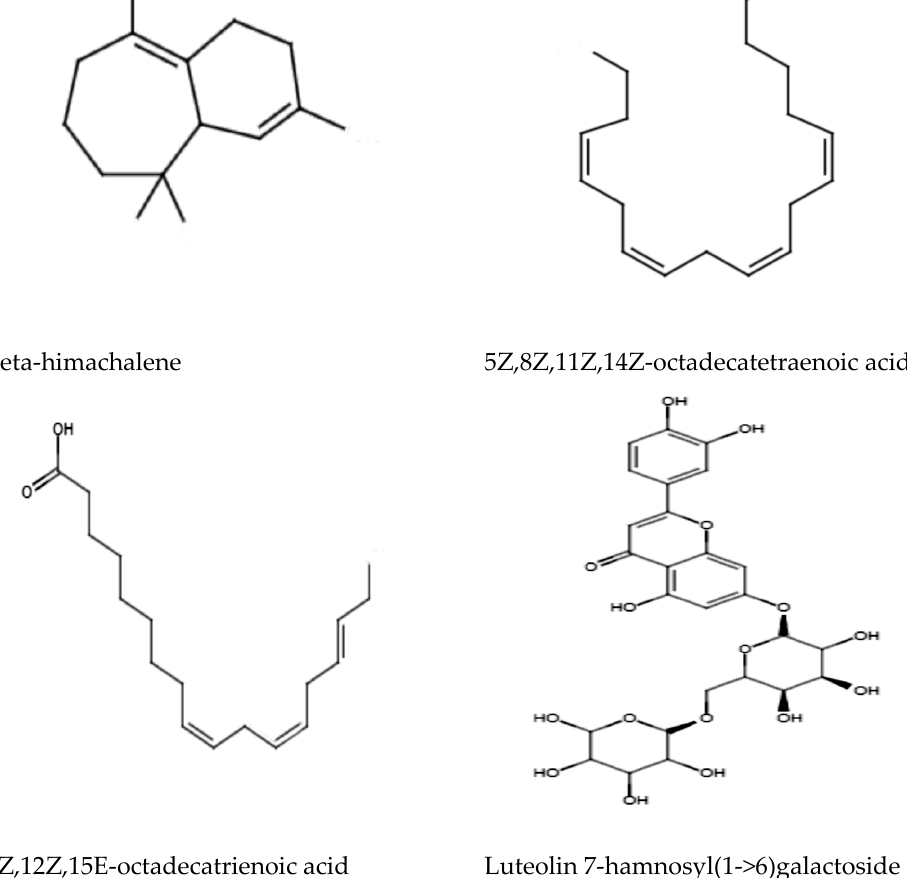
Figure 6. Antimicrobial phytochemical compounds found in the methanol extract of Polyalthia longifolia Leaf (MEPL) were detected using ultra high-performance liquid chromatography (UHPLC) equipped with the chemical library.